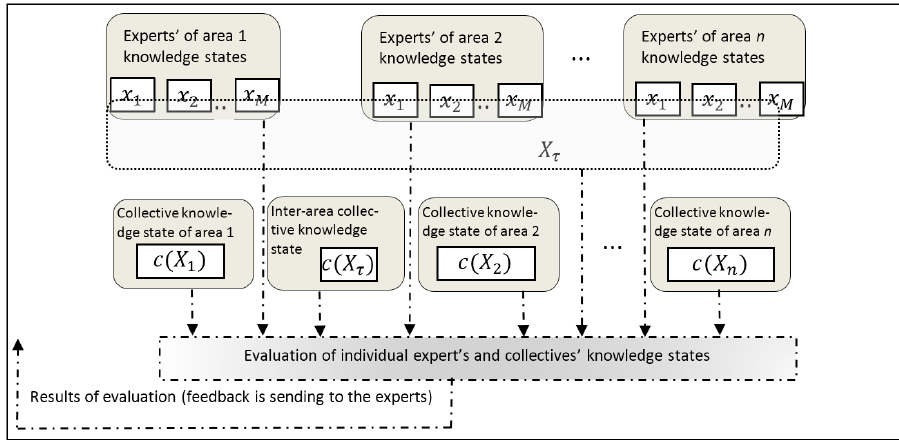
Fig. 3. Evaluation of a collective knowledge of business